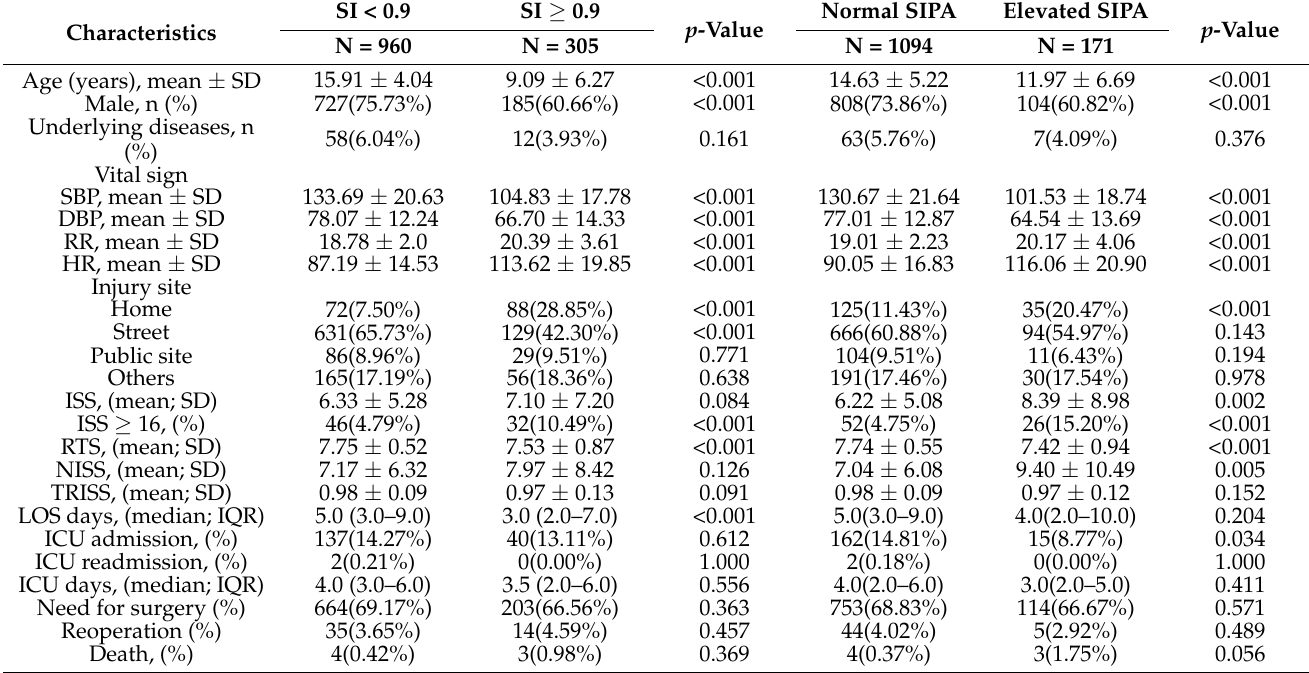
Table 3. Demographic population of elevated shock index and age-adjusted pediatric shock index.